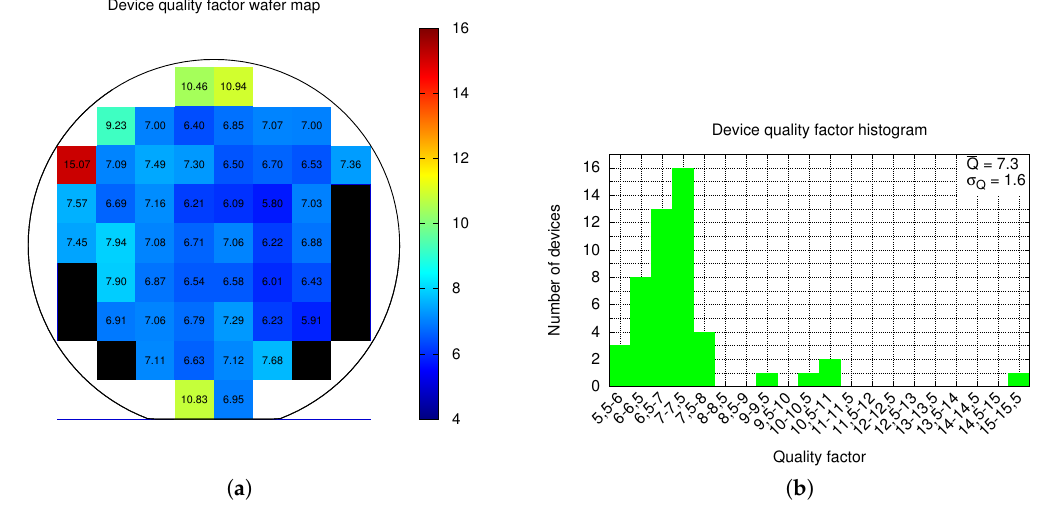
Figure 11. Wafer level device quality factor distribution map ( a ), and the histogram ( b